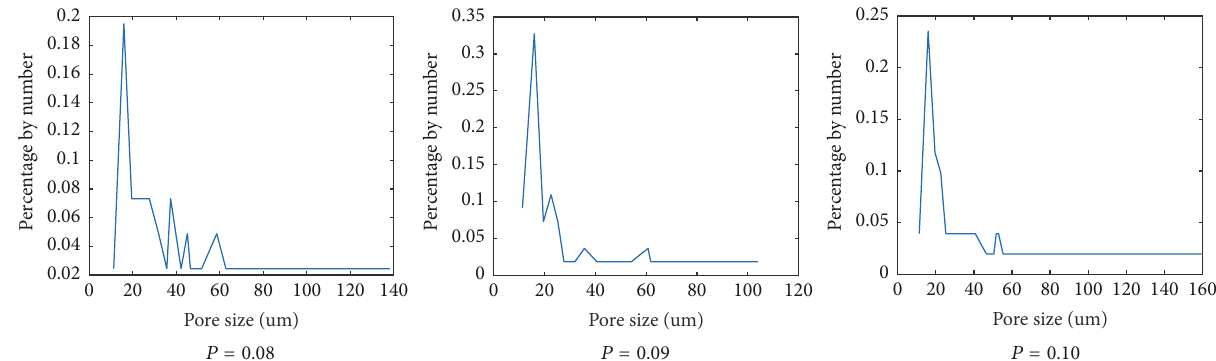
Figure 4: Distribution of 2D pore sizes in reconstructed porous media with different